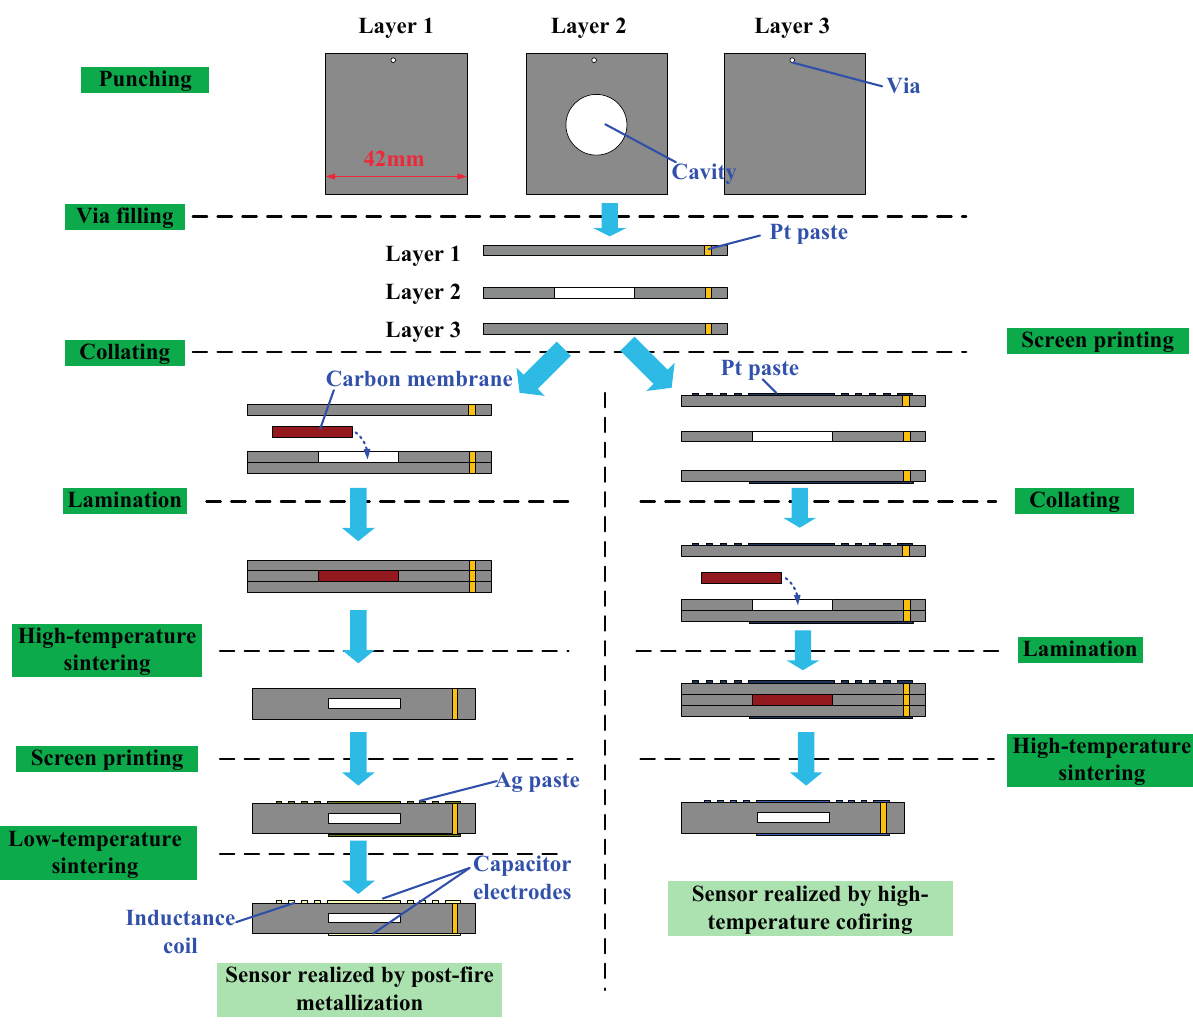
Figure 3. Fabrication process diagram of the